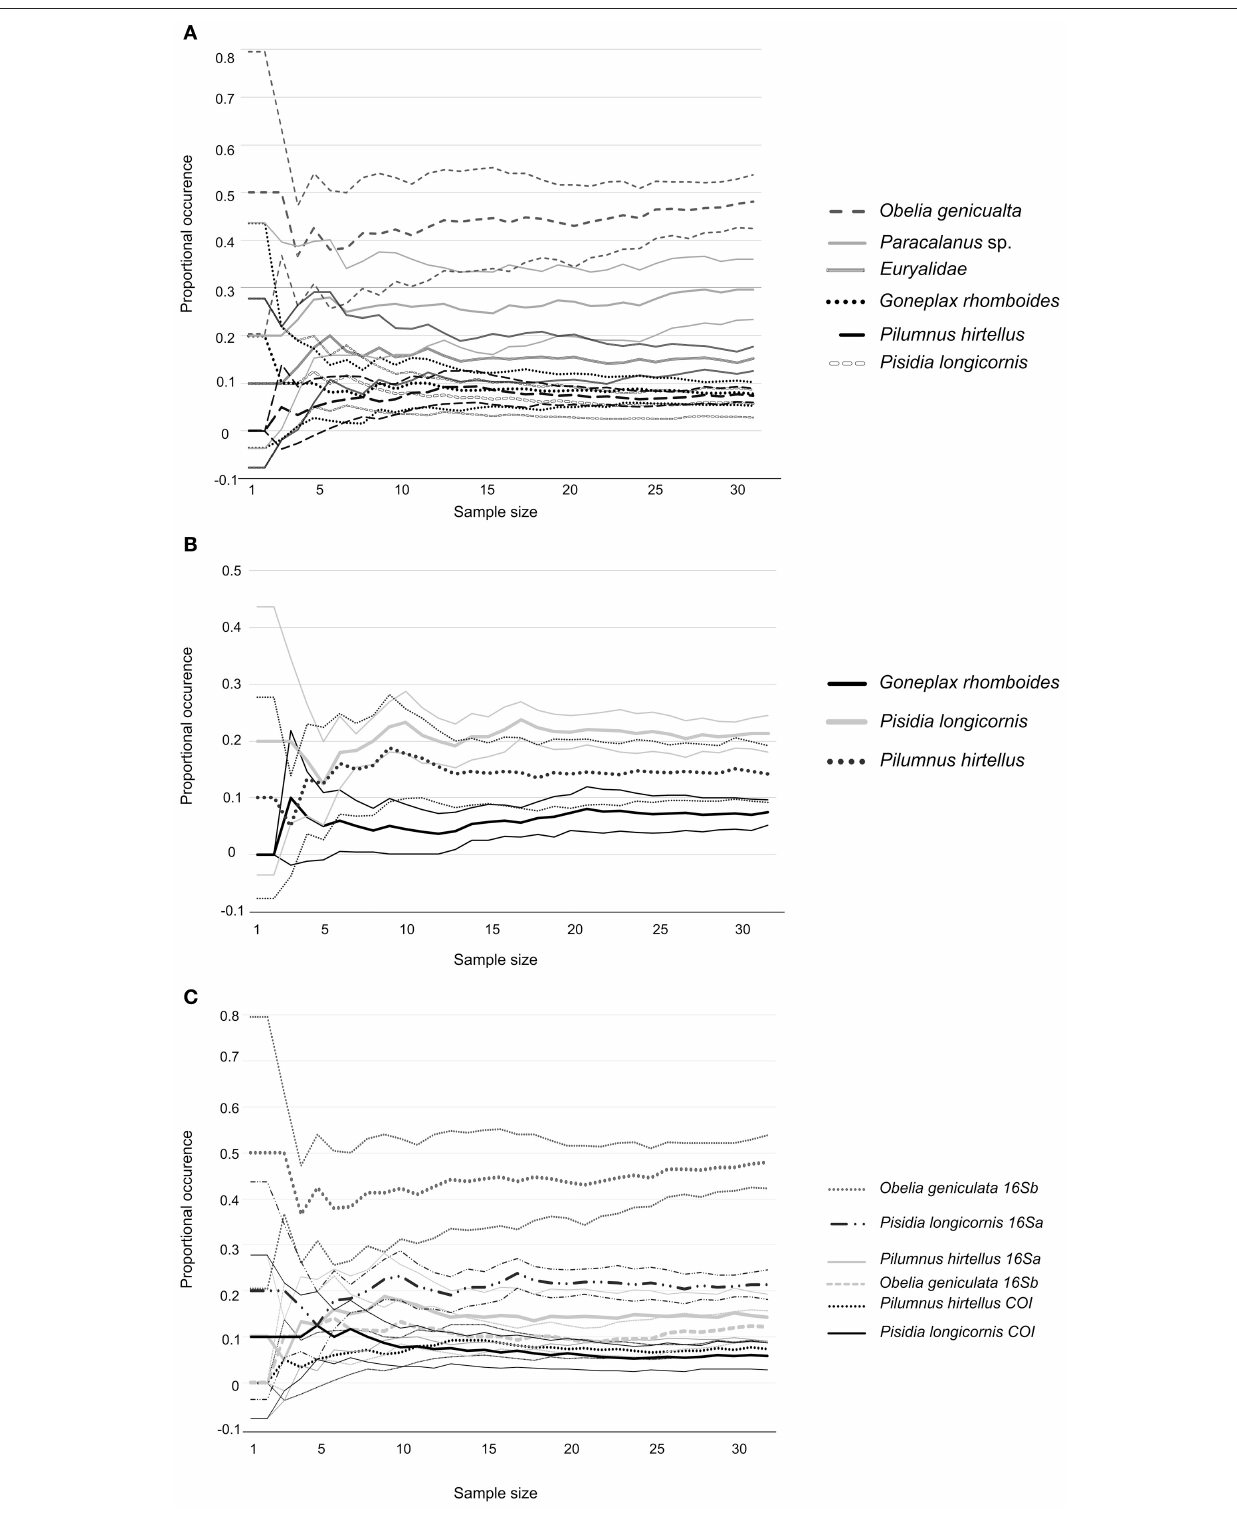
Frontiers in Physiology |